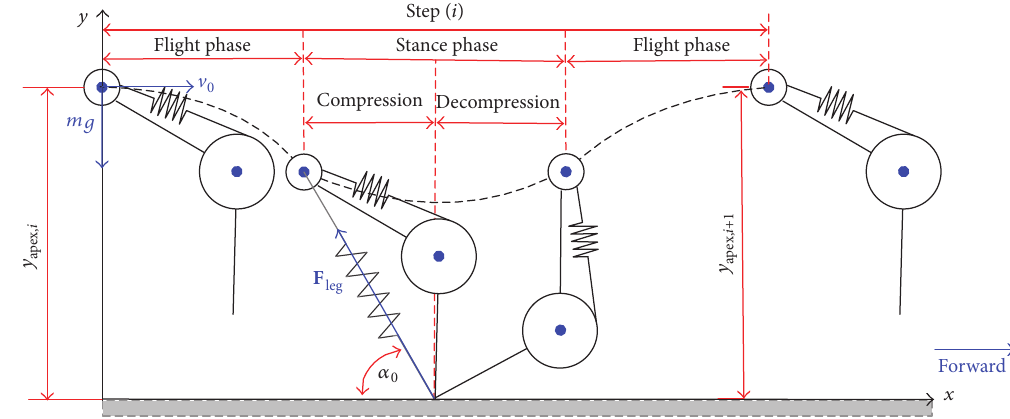
Figure 3: Two-segment leg model during a running period.